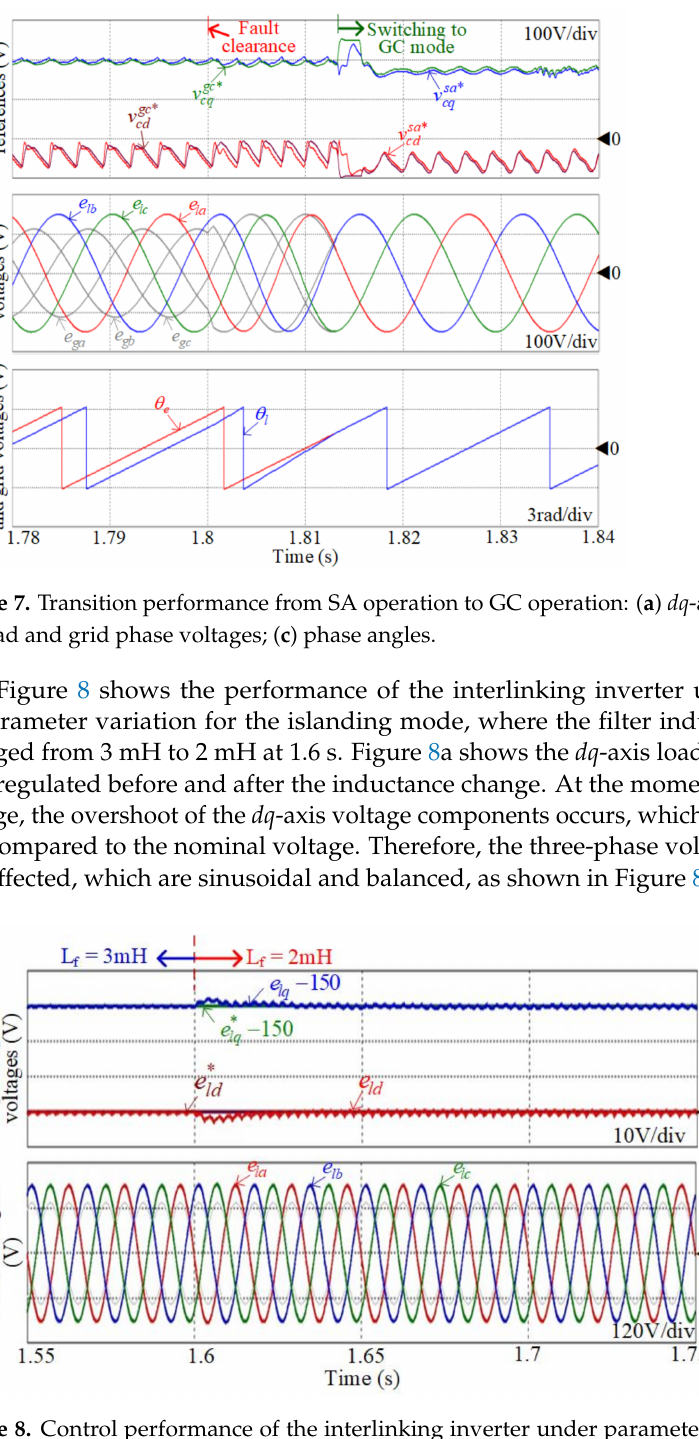
Figure 8. Control performance of the interlinking inverter under parameter variation: ( a ) dq -axis components of the load voltages; ( b ) load phase